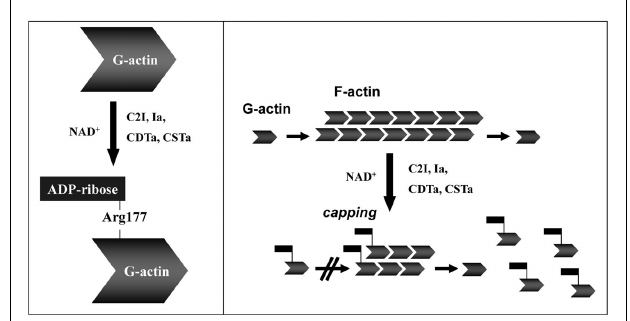
FIGURE 4 |Toxin-catalyzed mono-ADP-ribosylation of G-actin results in depolymerization of actin filaments (F-actin). Details are given in the